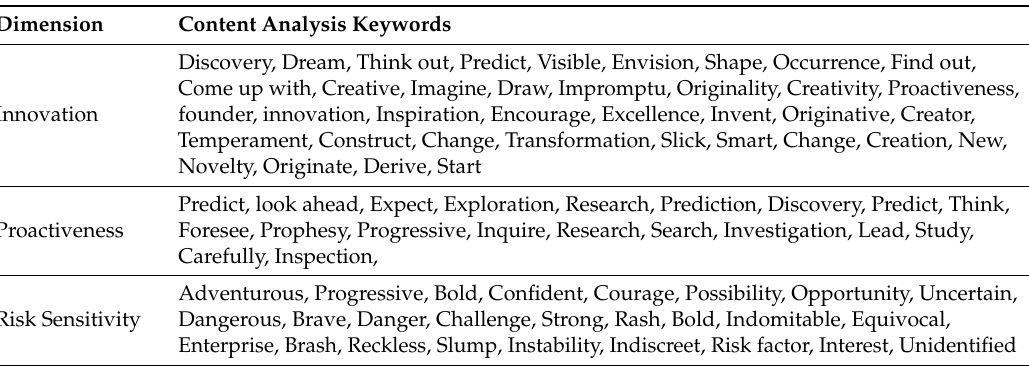
Table 1. Entrepreneurial orientation